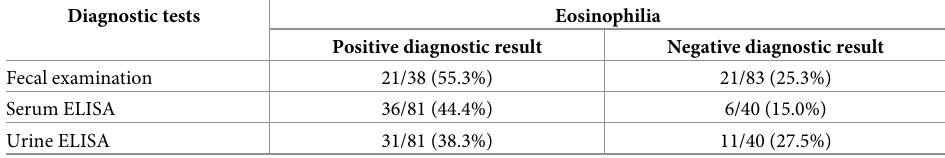
Table 5. The number of cases with eosinophilia as classified by results of each diagnostic methods. Absolute eosin- ophil count > 500 cell/μl =